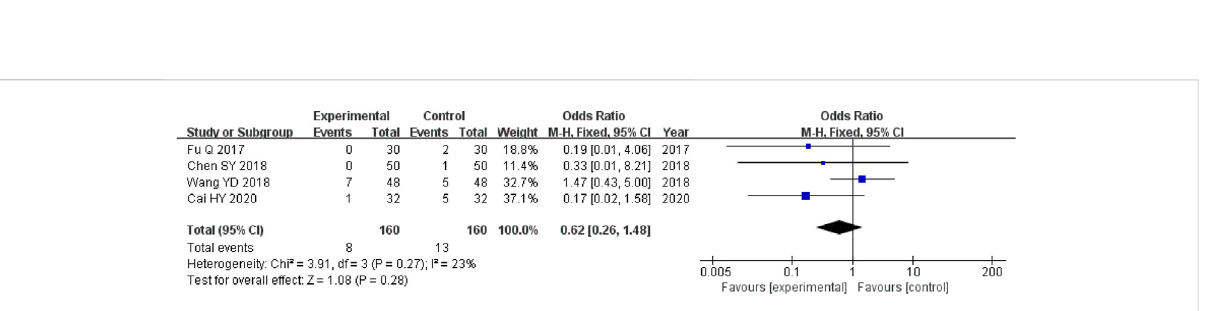
FIGURE 7 Comparative forest plot: incidence of adverse reactions. The pooled OR was 0.62 (95% CI 0.26 – 1.48, p = 0.28). There were no signi fi cant differences in the incidence of adverse events between the experimental and control cohorts.